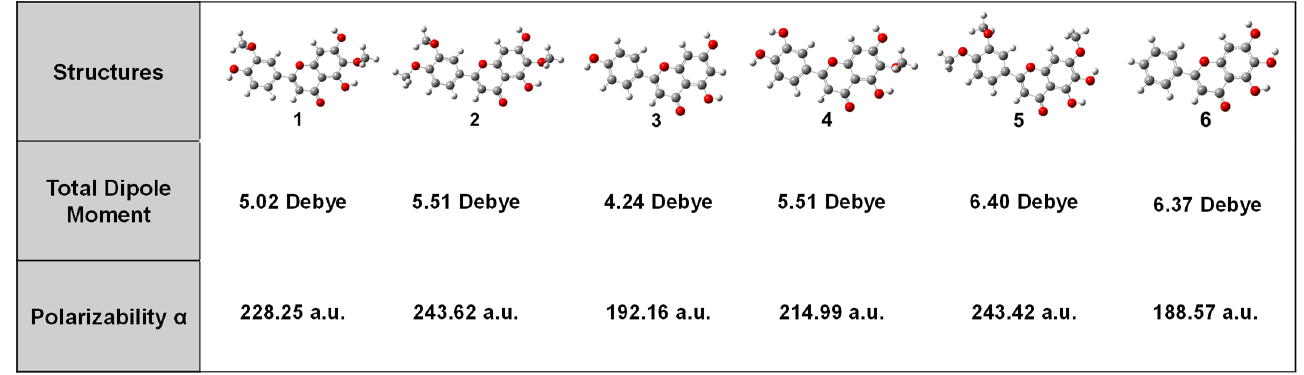
Figure 1. Optimized geometrical structures, dipole moment, and the polarizability of compounds 1 – 6 .